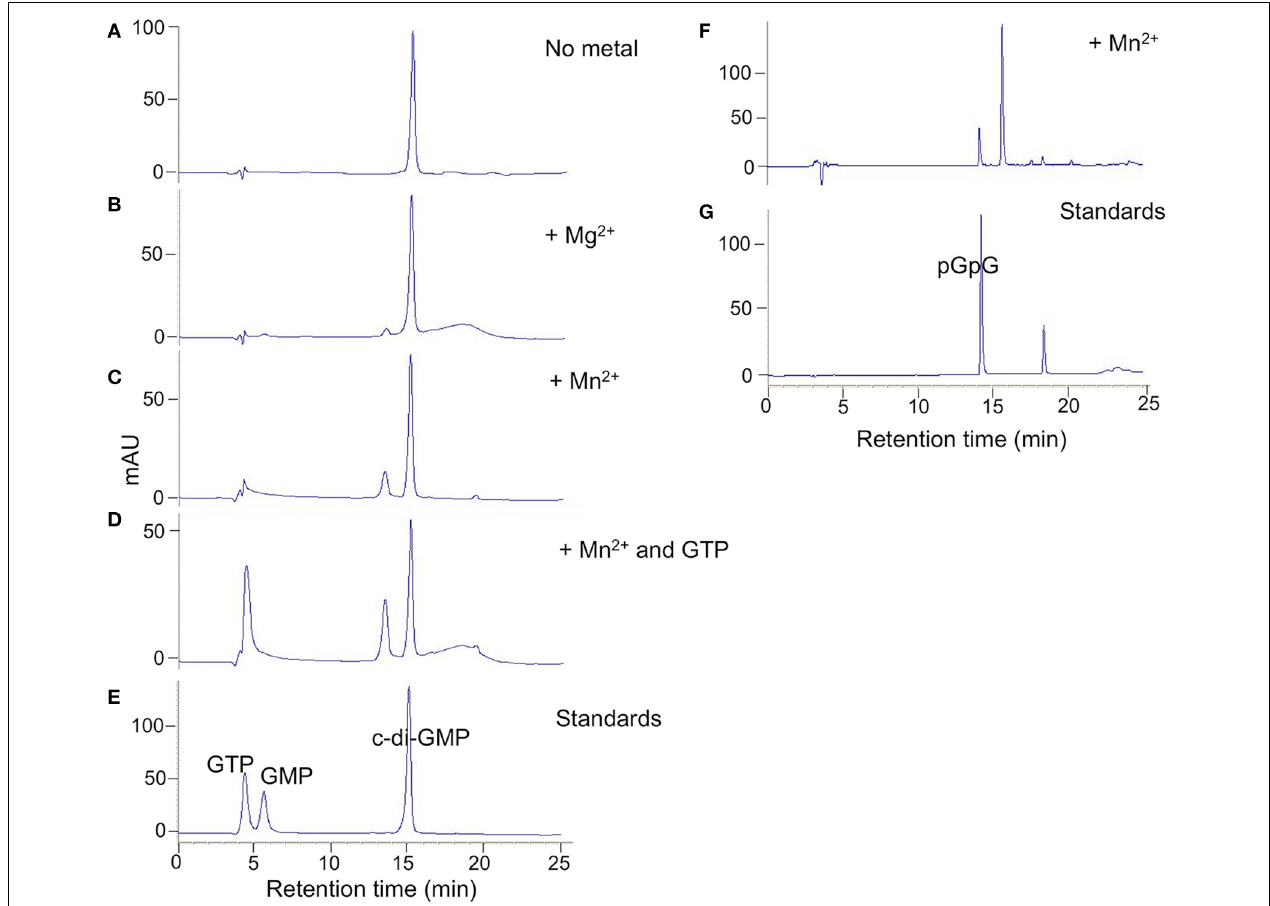
FIGURE 4 | DVU0408 has PDE activity. HPLC traces for PDE activity assays with purified DVU0408 and 100 μ M c-di-GMP in the presence of no metal (A) ; 2mM MgCl 2 (B) ; 2mM MnCl 2 (C,F) ; 2mM MnCl 2 and 100 μ M GTP (D) . Standards in (E) were a mix of 100 μ M